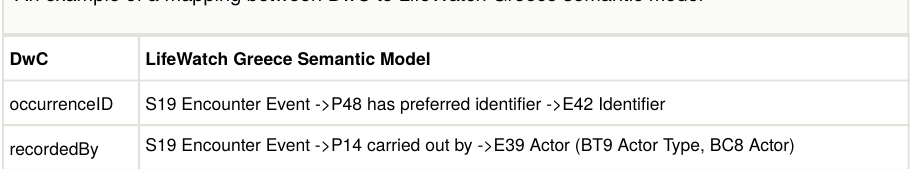
An example of a mapping between DwC to LifeWatch Greece semantic